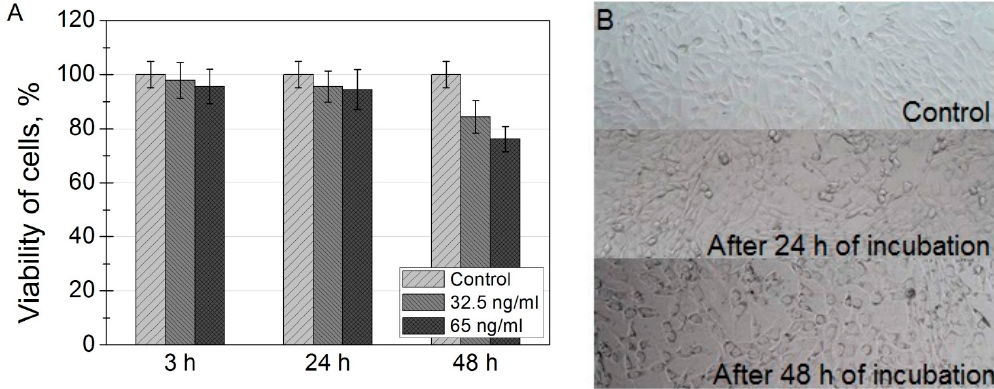
Figure 2. Fixed NIH3T3 cells after 0.5–72 h of incubation with 65 ng/mL of Fe 3 O 4 (stained with Prussian Blue) ( A – F ). The accumulation was observed using bright-field microscope equipped with digital color camera.